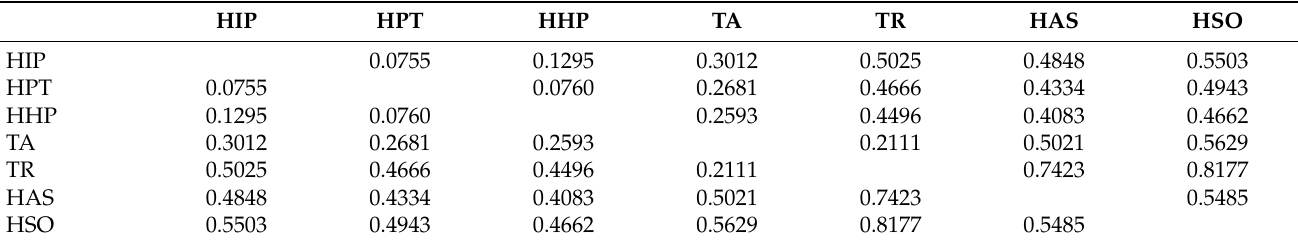
Table 5. Pairwise genetic differentiation (Fst) values among 7